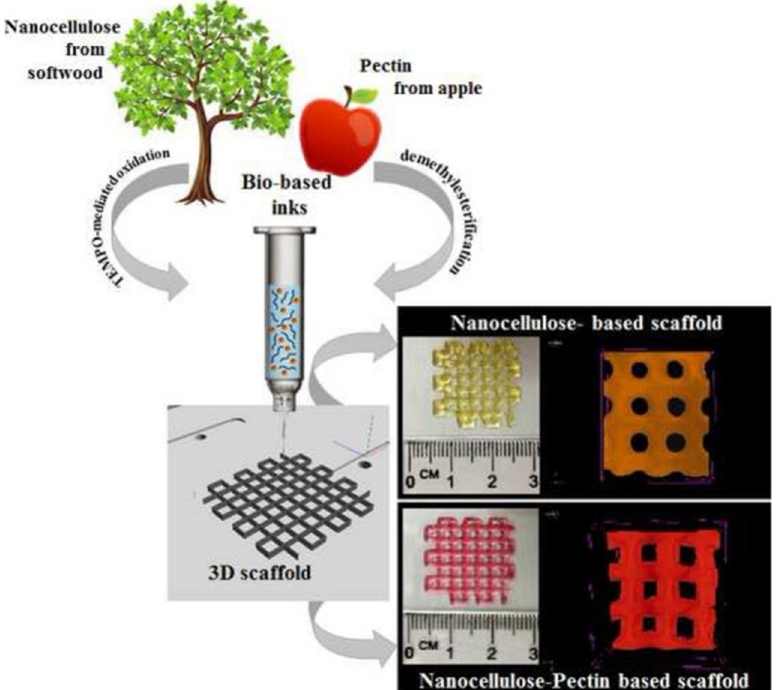
Figure 3. Pectin reinforced with the carboxylated cellulose nanofibrils for the production of bio-based inks for 3D printing of scaffolds. Reprinted with permission from ref. [33]. Copyright 2019 Elsevier.